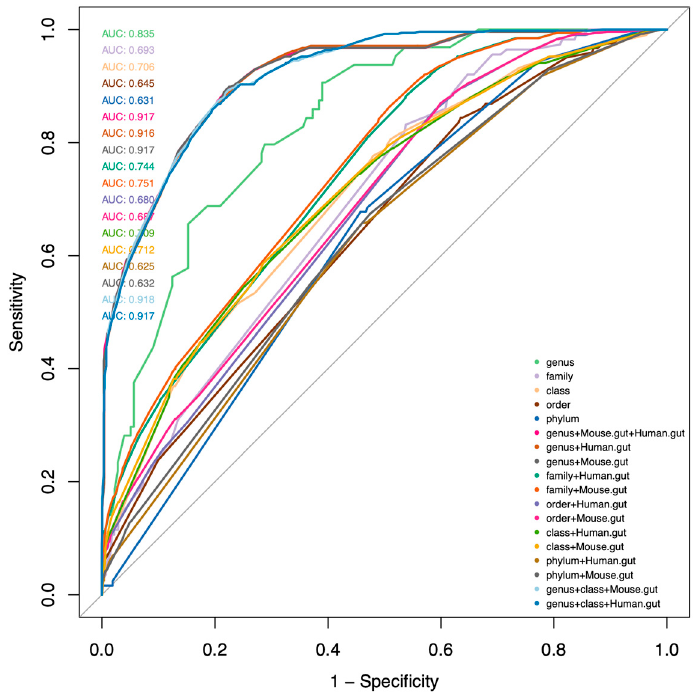
Figure 5. ROC plot for top-ranked IAA models based on prediction of stimulated data. The curves are colored by different models which use different predictors as listed for predicting IAA production.